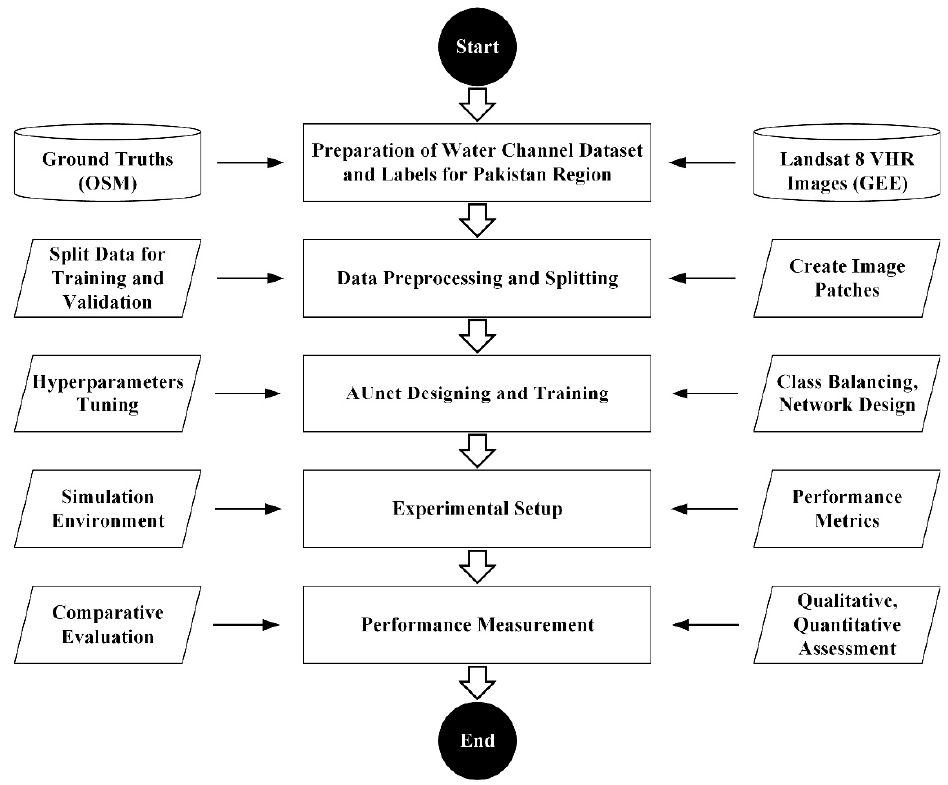
Figure 4. Flowchart of the proposed research.